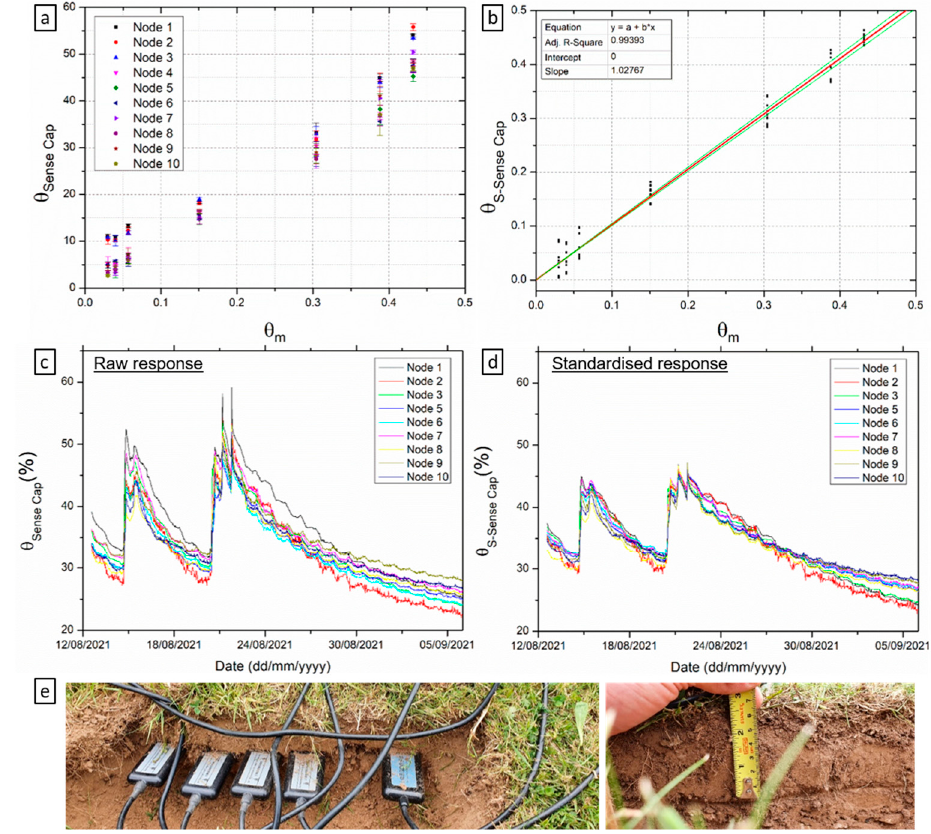
Figure 3. Raw and standardized response from the Sense Cap units. ( a ) raw sensor response with increasing θ m in prepared soil samples, error bars represent the standard deviation of at least 9 measurements, 3 measurements at 3 different positions in the sample ( b ) standardised sensor re- sponse to θ and linear relationship between actual and estimated θ ; ( c ) raw response time-series data; ( d ) standardised response time-series data; ( e ) experimental set-up for data in ( c ) showing sensor installation within close proximity to each other, at approximately 5 cm